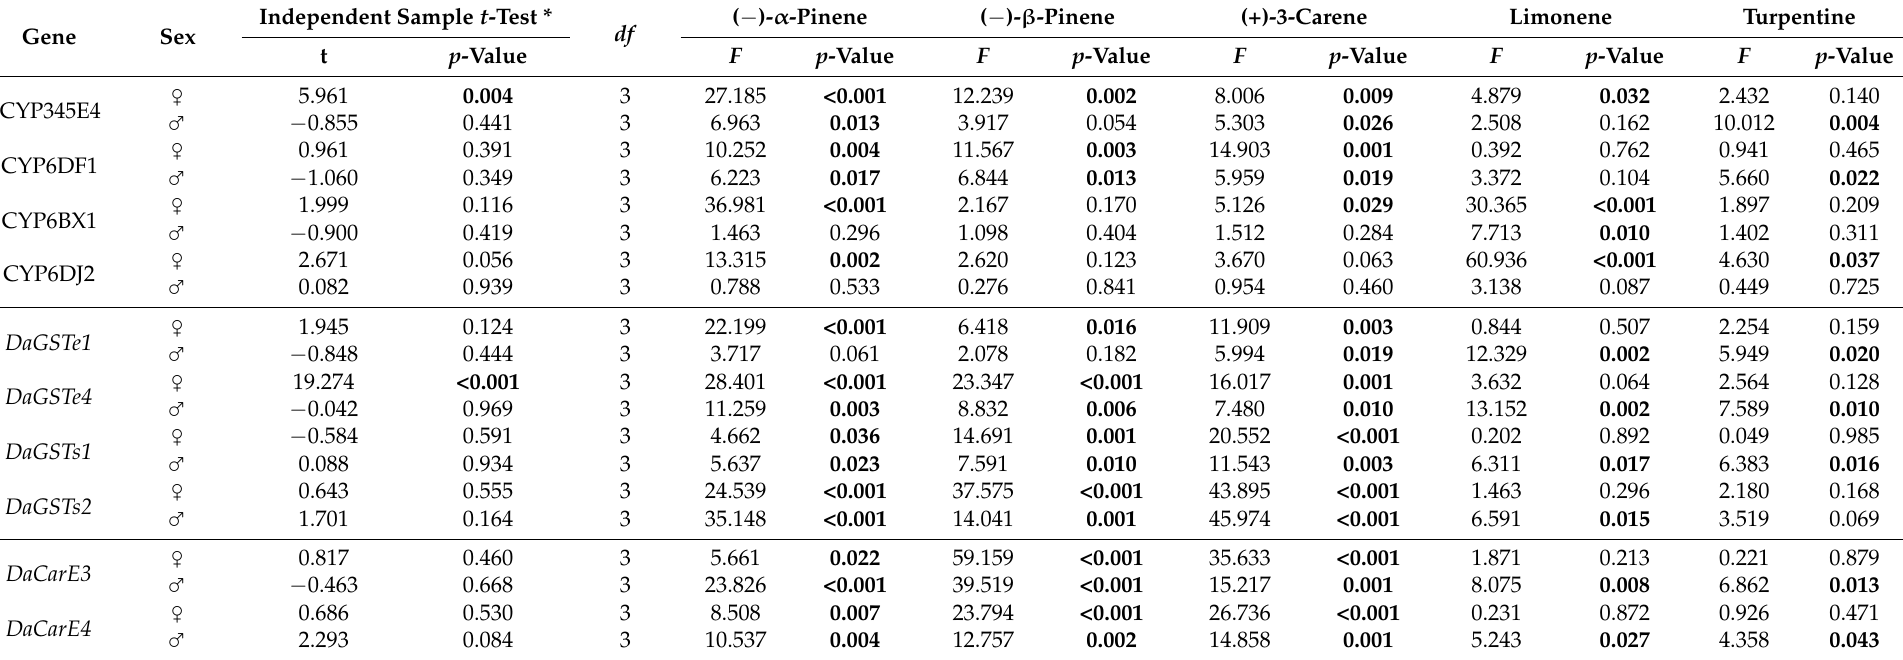
Table 3. One-way ANOVA analysis of detoxifying enzyme gene expression from D . armandi with each stimulus at different